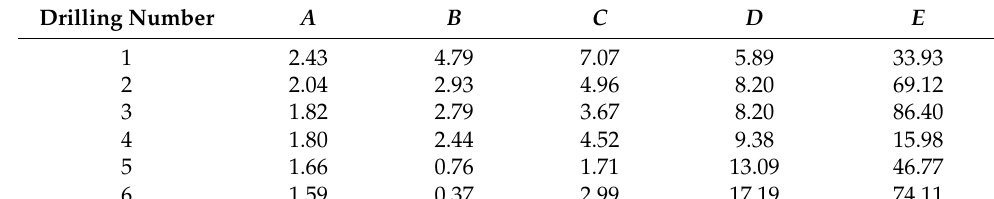
Table 2. High-pressure pipeline section analysis data.